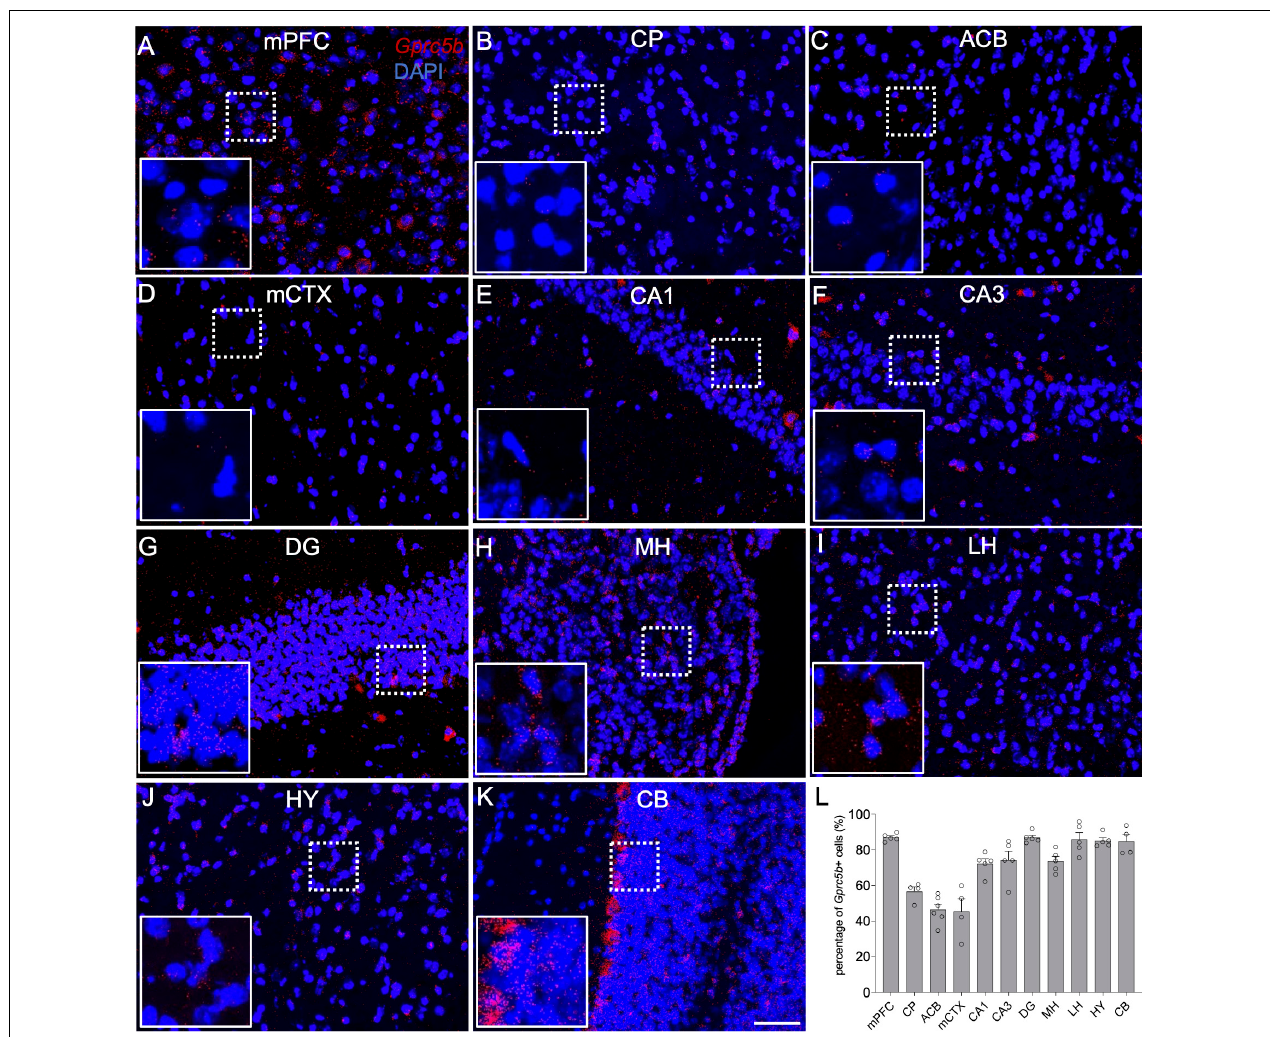
FIGURE 5 | Representative images demonstrating spatial profiling of Gprc5b expression on coronal sections from adult mice. (A) Medial prefrontal cortex (mPFC), (B) caudate putamen (CP), (C) nucleus accumbens (ACB), (D) motor cortex (mCTX), (E) hippocampal CA1, (F) hippocampal CA3, (G) hippocampal dentate gyrus (DG), (H) medial habenula (MH), (I) lateral habenula (LH), (J) hypothalamus (HY), (K) cerebellum (CB). (L) Percentage of Gprc5b positive cells across the abovementioned regions. Each data point represents calculated percentage of Gprc5b positive cells from a single section sampled from 2 to 4 animals and results are reported as mean ± SEM. Scale bar: 50 µ